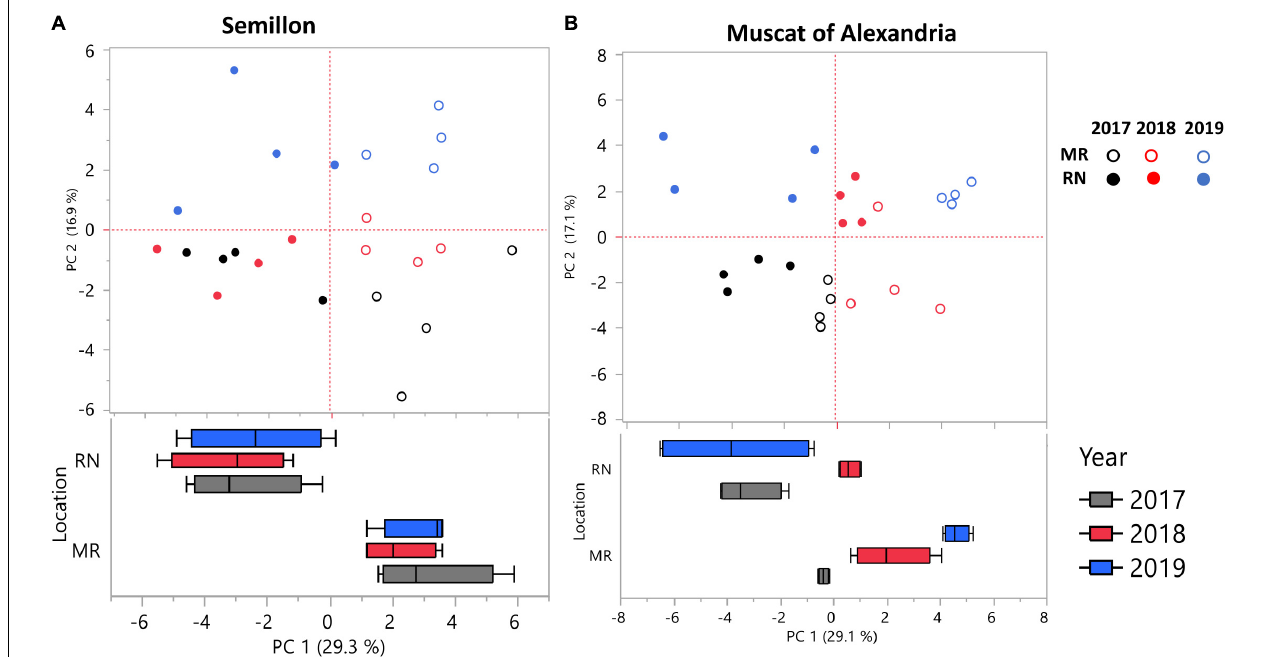
FIGURE 5 | Principal component analysis (PCA) of skin phenylpropanoids at harvest for cultivars affected by location (L) and season (Y) (A) , and their interaction (B) . (A) PCA performed on skin phenylpropanoids of the Semillon cultivar shows that samples are significantly separated by their location, i.e., Ramat Negev (RN) or Mitzpe Ramon (MR). (B) PCA performed on skin phenylpropanoids of the Muscat of Alexandria cultivar shows that sample separations are significantly influenced by the L × Y interaction. Data were scaled to the median of each metabolite, and the value of four biological replicates ( n = 4) in each season and location were used to plot the PCs. The PCA was first plotted for each cultivar, and a two-way ANOVA model was performed using PCA scores for each cultivar separately. The analysis resulted in the identification of two subsets of cultivars; (i) cultivars affected by location and seasons, and (ii) cultivars affected by L × Y interactions. Only one representative cultivar, (A,B) from each group is depicted. Box plots were generated using the first PC